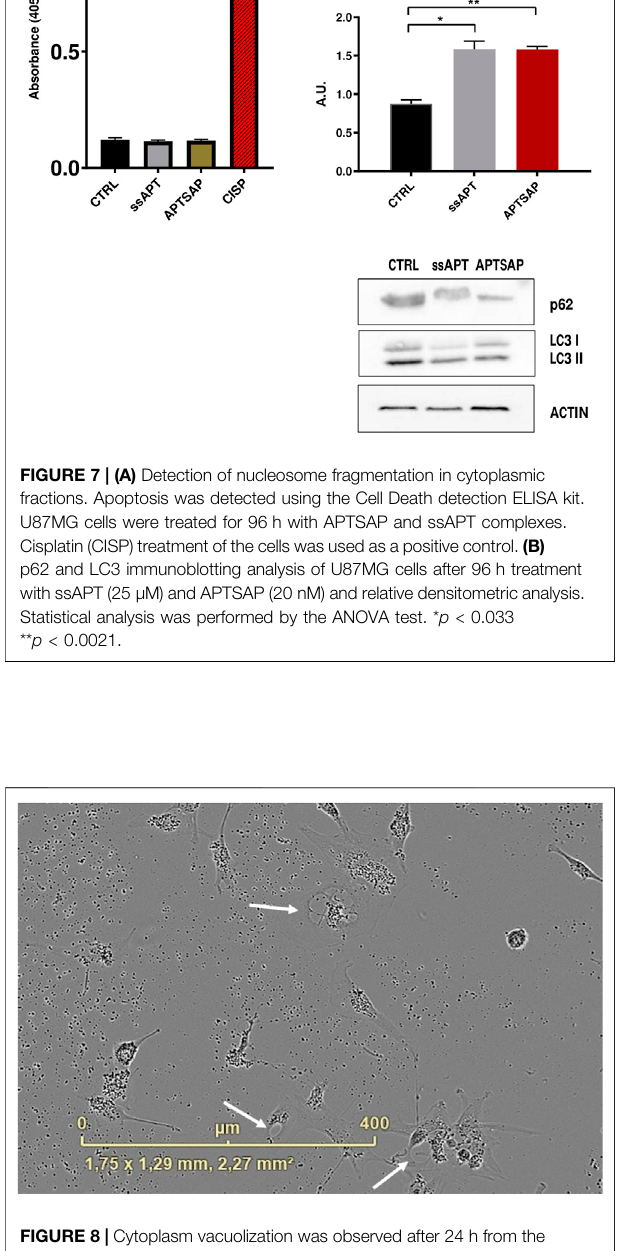
FIGURE 8 | Cytoplasm vacuolization was observed after 24 h from the APTSAP transfection of U87 cells with PEI (1:1, gene to PEI ratio, 10 μ g/ml). The image was recorded using the IncuCyte ZOOM ® live cell imaging system.